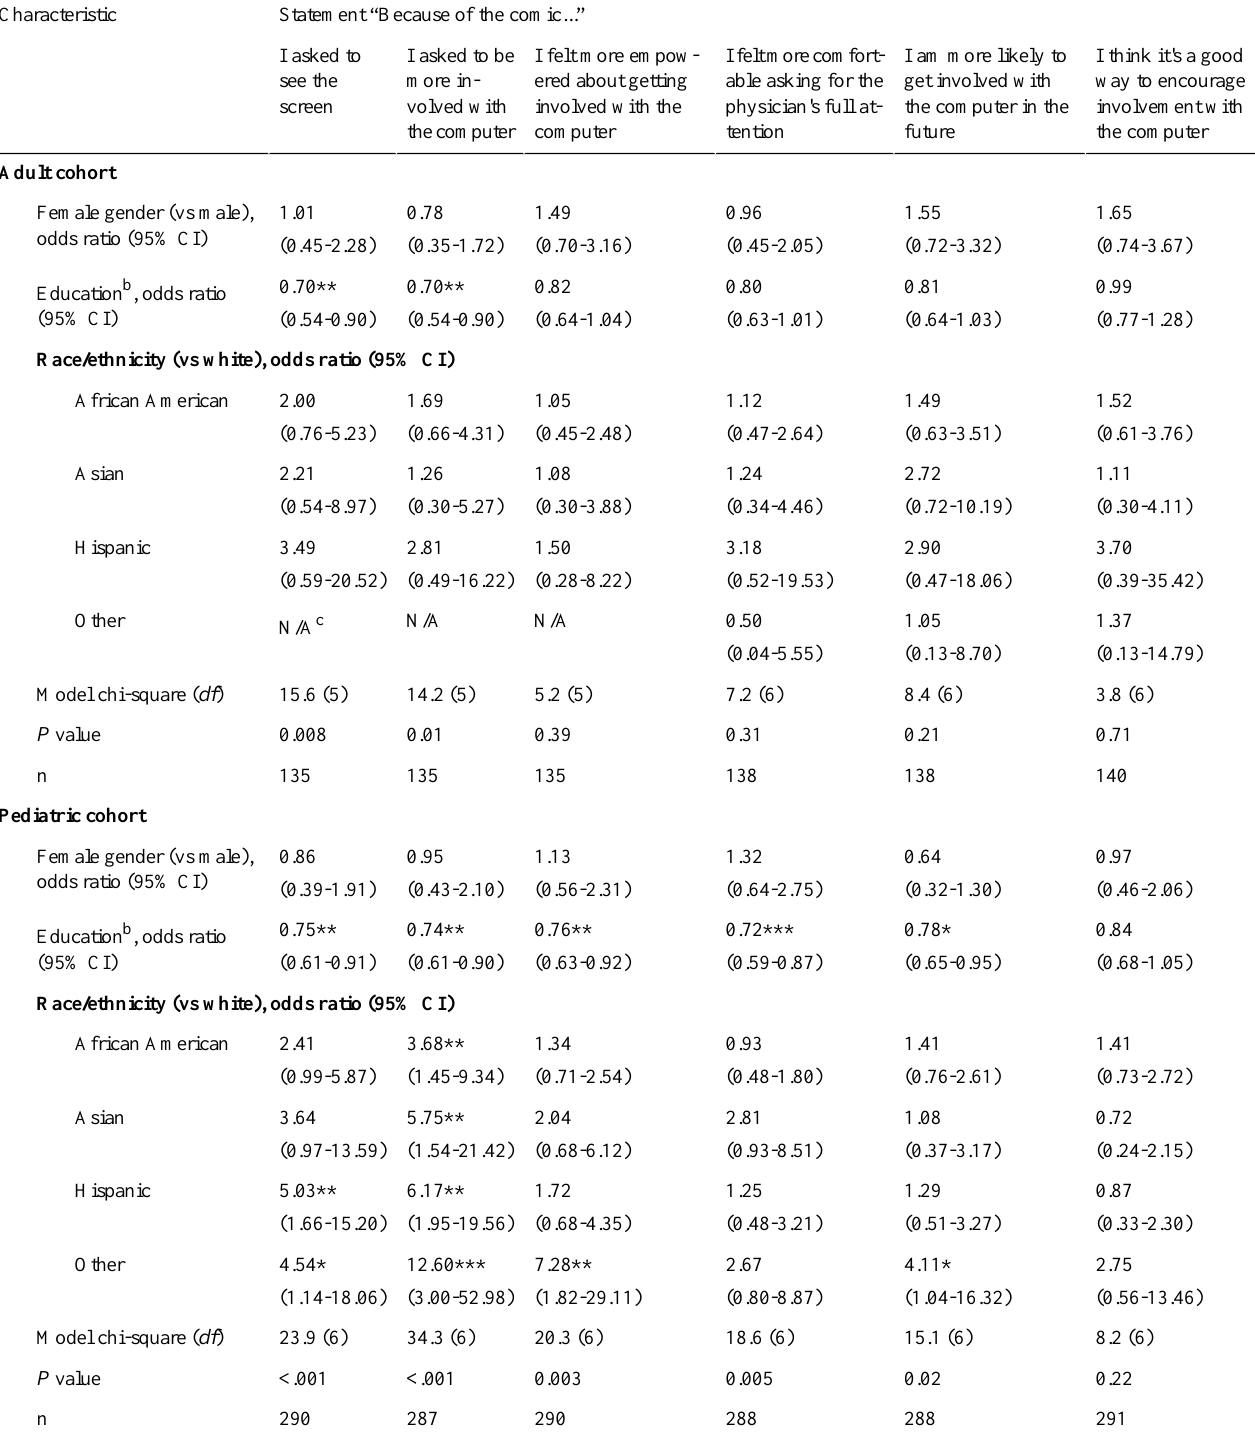
a Numbers in table are odds ratios (95% CI) from 6 separate multivariate logistic regression models for agreeing with given statement (agree or strongly agree vs not). * P <.05, ** P <.01, *** P <.001. b Treated as a continuous measure using integer scores for educational level (higher scores = more education). c Not